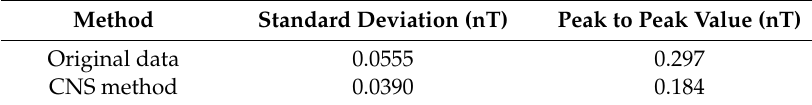
Table 5. Standard deviation and peak to peak value of the flight survey line-1.